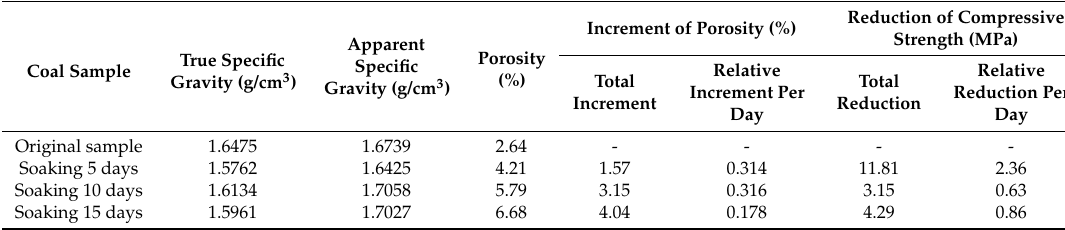
Table 2. Test results of specific gravity and porosity of coal samples.